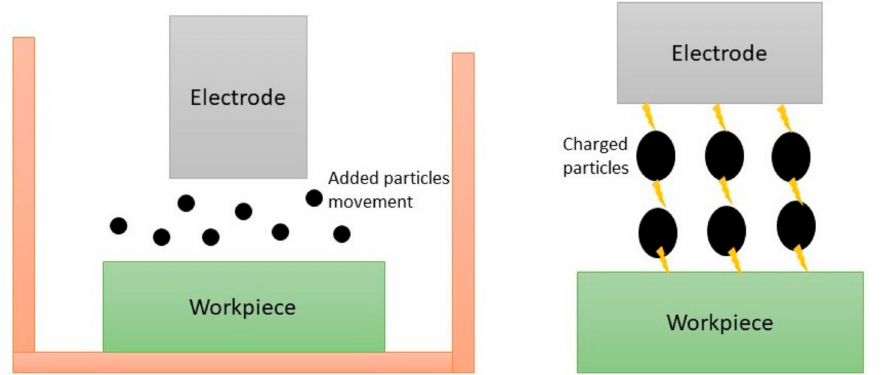
Figure 2. Mechanism of the added particle movement and chain formation reproduced with permis- sion from ref. [57].